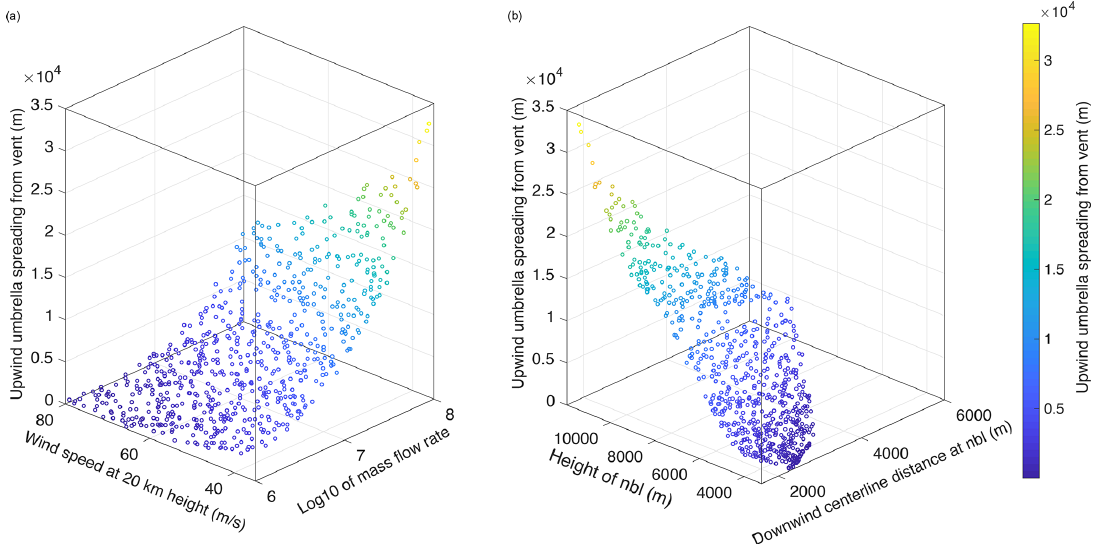
Figure 12. Upwind spreading of the umbrella cloud as a function of wind speed at tropopause and mass flow rate (a) and plume model output parameters (b) . Please note that in the left panel also the specific humidity at sea level is varied, without producing significant variations in the upwind